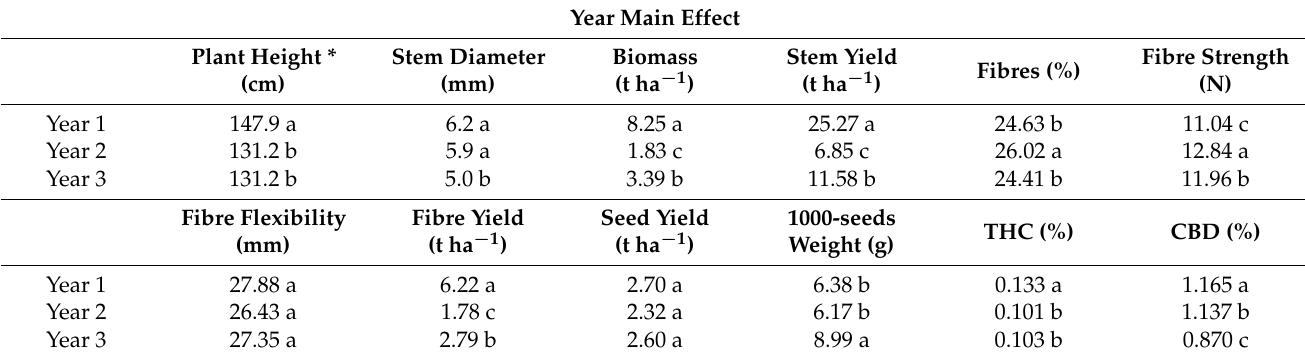
Table 2. Year main effects for the hemp characteristics evaluated during the